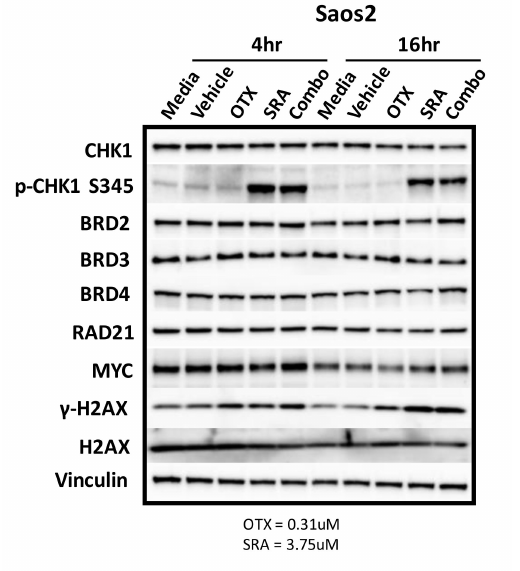
Figure 6. BET inhibition as a single agent or in combination with CHK1i / SRA737 does not decrease the MYC protein. Saos2 cells were treated with controls (media and vehicle), as well as single-agent and combination therapy involving BETi / OTX-015 (0.31 µ M) and / or CHK1i / SRA737 (3.75 µ M) for 4 or 16 h. Concentrations were obtained from data in Table 2a. Vinculin serves as the loading control. This was performed once. OTX = BETi / OTX-015 and SRA = CHK1i /